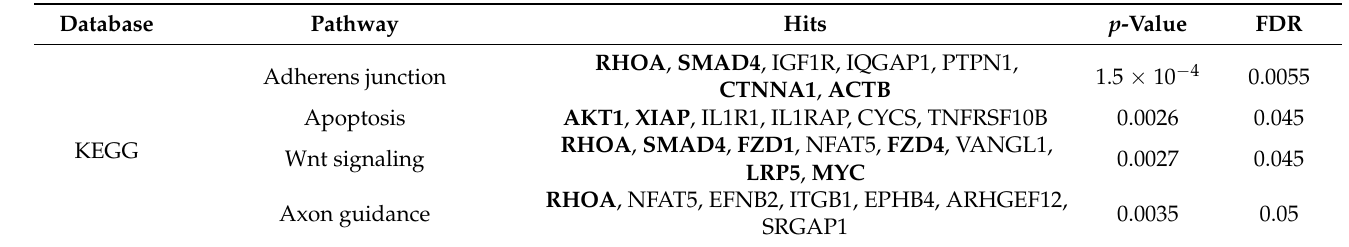
Figure 5. Target analysis of miRNAs rescued by insulin (Table 2) using miRnet. Seven miRNAs identified as significantly dysregulated by the diabetic phenotype in ZDF rats and rescued by insulin to WT levels were used to construct a target network using the online tool miRnet with a degree filter set to 2. Table 4. Pathway enrichment using the KEGG, Reactome, and DisGeNET databases. Several pathways significantly enriched with an adjusted p value < 0.2 (FDR < 20%) were identified for the seven miRNAs rescued by insulin. The top targeted genes most commonly present in the identified pathways are highlighted (19